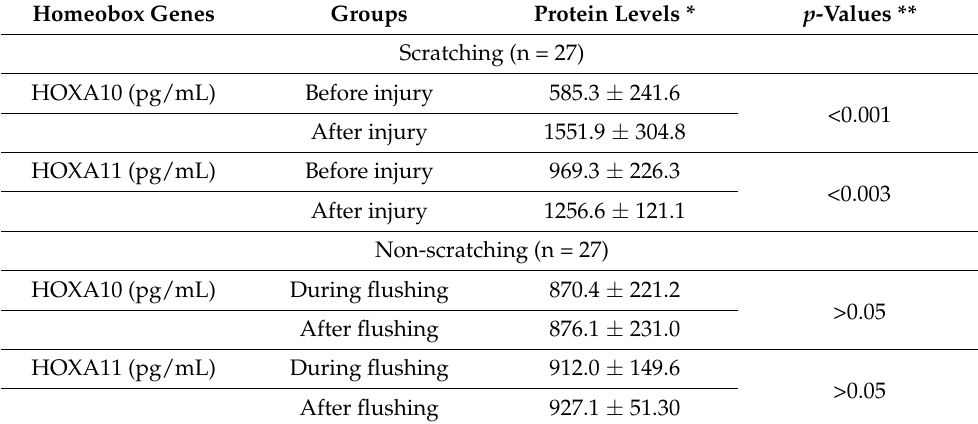
Table 3. Concentrations of endometrial HOXA10 and HOXA11 proteins in the scratching and sham